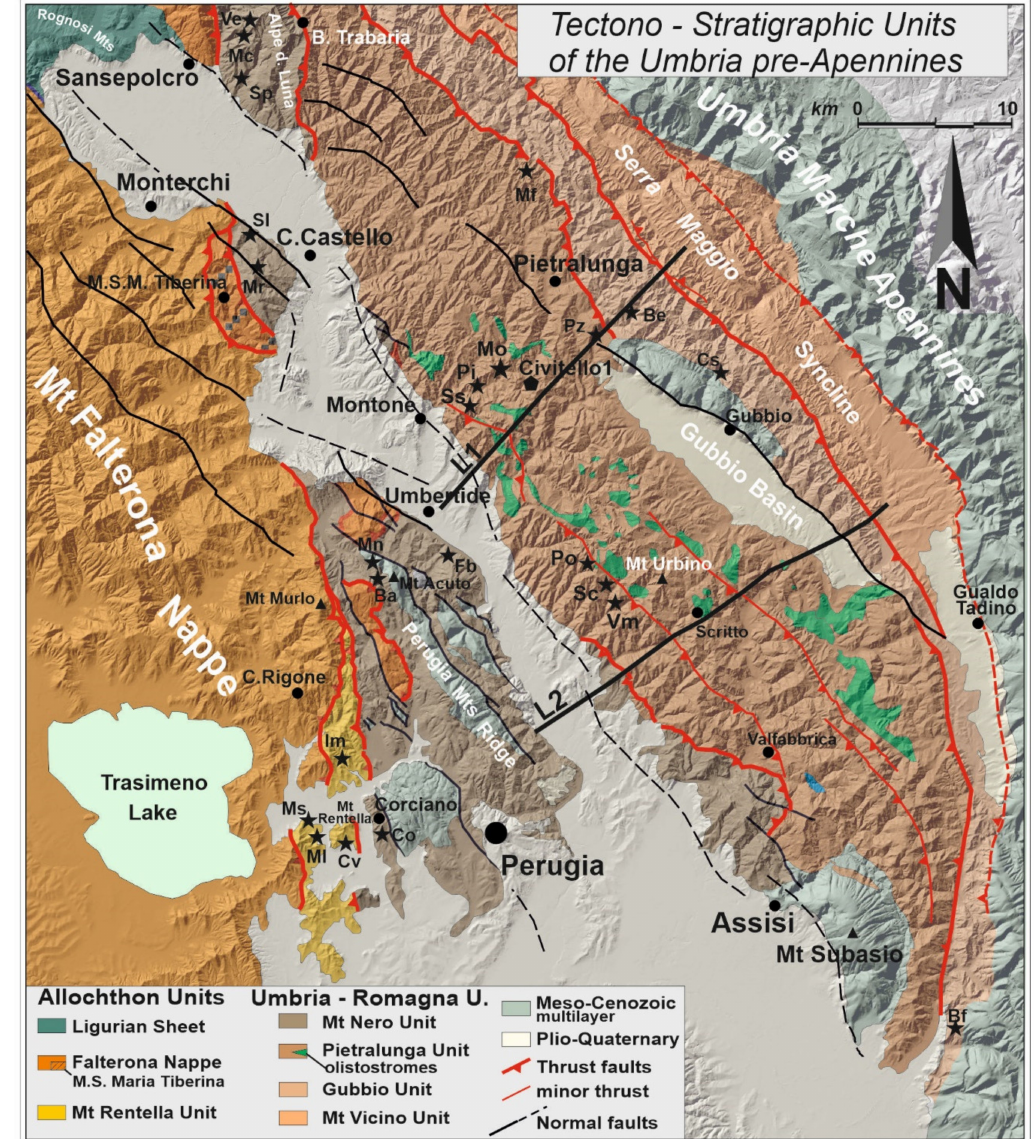
Figure 1. Structural Geological scheme of the study area showing the main tectono-stratigraphic units in which the Early-Middle Miocene Marnoso Arenacea basin is presently split according to the data reported in [10–16]. Asterisks and acronyms locate the studied sections as explained in the following: REN Unit: Ml = I Molini, Ms = Monte Sperello, Cv = Castelvieto, Im = Il Molino; Mt Nero Unit: Ba = Balconcelli, Co = Corciano, Mn = Monestevole, Fb = Fosso della Badia, Sp = Case Spertaglia, Mc = Monte Casale, Ve = Vesina; M. S. Maria Tiberina area: Sl = San Lorenzo, Mr = Monte Cedrone; Pietralunga Unit: Pz = Piazze, Sc = Santa Cecilia, Po = Portole, Vm = Valmarcolone, Ss = Sassarone, Pt = Pietralata, Mo = Moravola; Gubbio Unit: Cs = Contessa, Be = Bavelle; Mf = Madonna dei 5 Faggi, Bf =